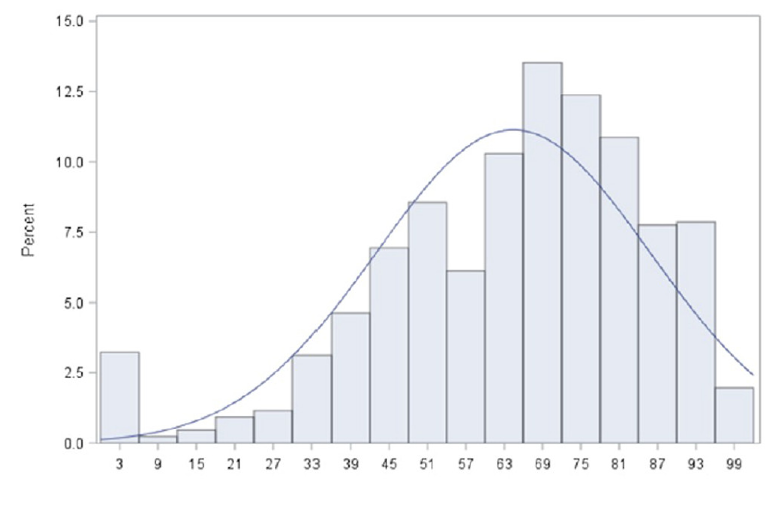
Figure 2. Distribution of PB-HIV Index score in people living with HIV